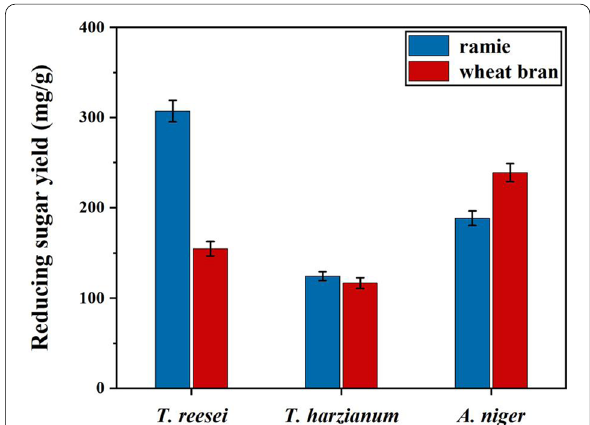
Fig. 5 The effect of wheat bran or ramie substrate on the enzymatic